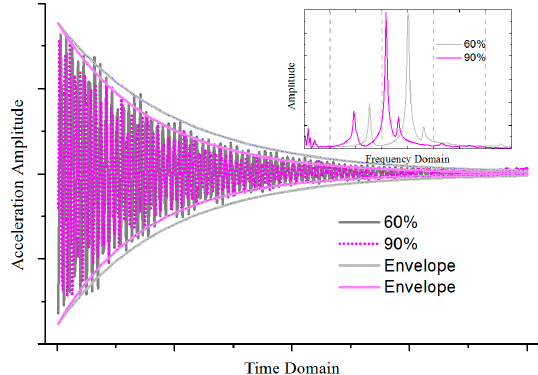
Figure 5. Time frequency analysis of the vibration signal.